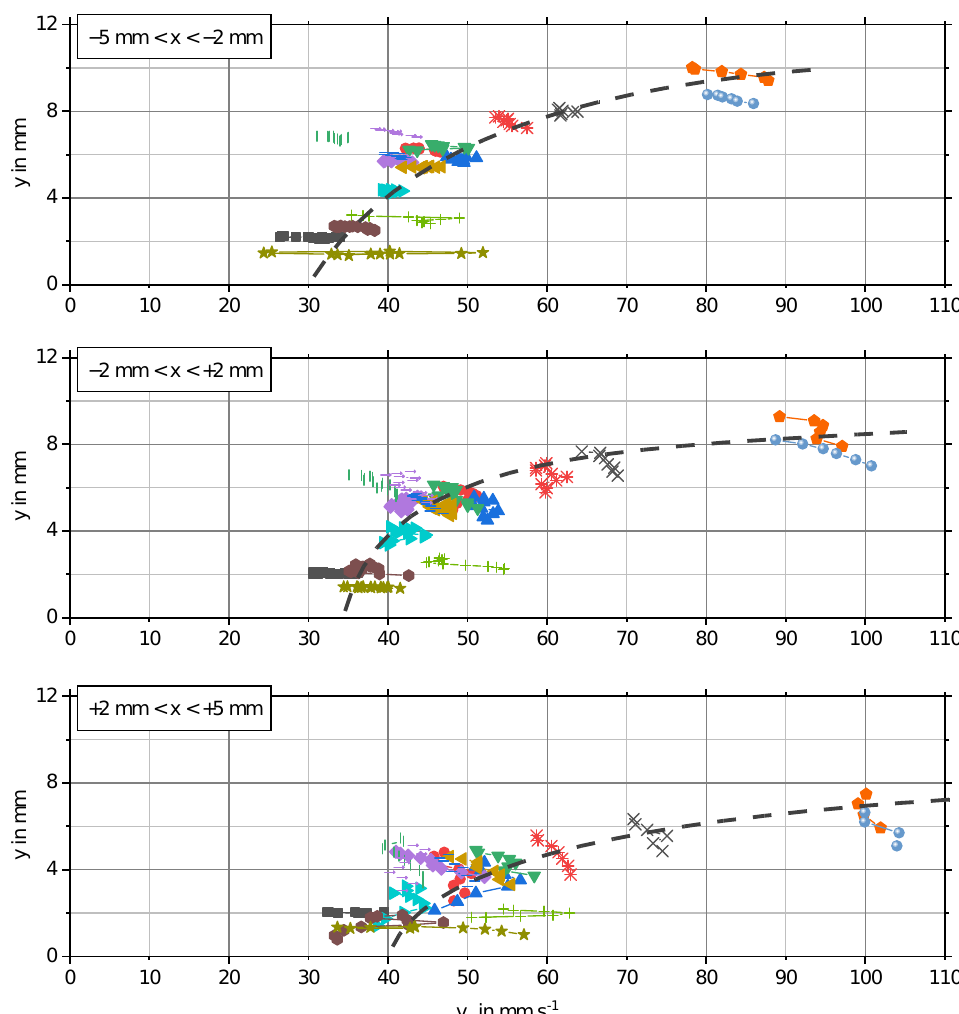
Figure 9. Tracer particles in the central measuring plane ( z 0 = 0mm) at the weir: the horizontal velocity component v x is plotted against the vertical position y above the weir. The overall velocity level is slightly increasing, while the liquid foam ( c 1 = 1.0gL − 1 ) with the tracer particles approaches the weir crest ( − 5mm < x < − 2mm, plot on the top), flows over it ( − 2mm < x < + 2mm, plot in the middle), and moves on ( + 2mm < x < + 5mm, plot on the bottom). More importantly, v x increases in vertical direction y by tendency, emphasised by the grey dashed trend line in each plot. The same tracer particle is indicated by the same symbol and colour in all three